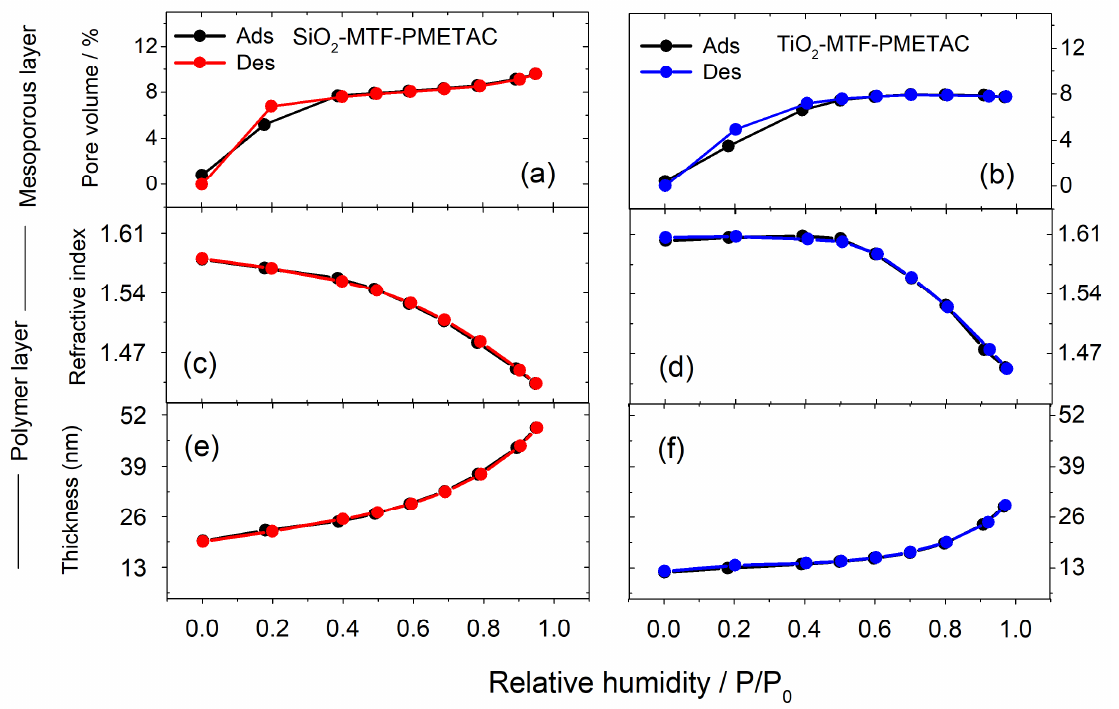
Figure 4. A two-layer model for the EEP measurements: mesoporous layer and a polymer overlayer. Accessible pore volume of the mesoporous silica ( a ) or titania layer ( b ) is shown. The variation of the PMETAC overlayer refractive index for silica or titania systems is given in ( c ) and ( d ), respectively. The PMETAC overlayer thickness for silica or titania systems is shown in ( e ) and ( f ), respectively, for increments of relative humidity.